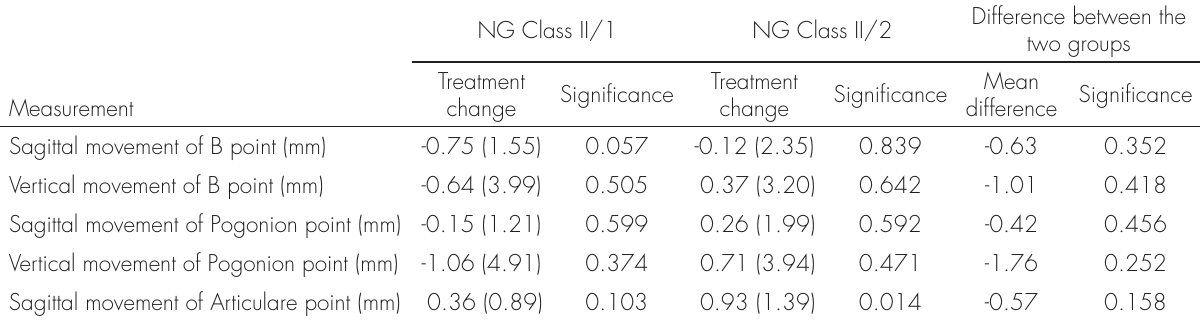
Table VI. The linear measurements that represent average changes in the mandibular position for both non-growing (NG) groups with their statistical significance.